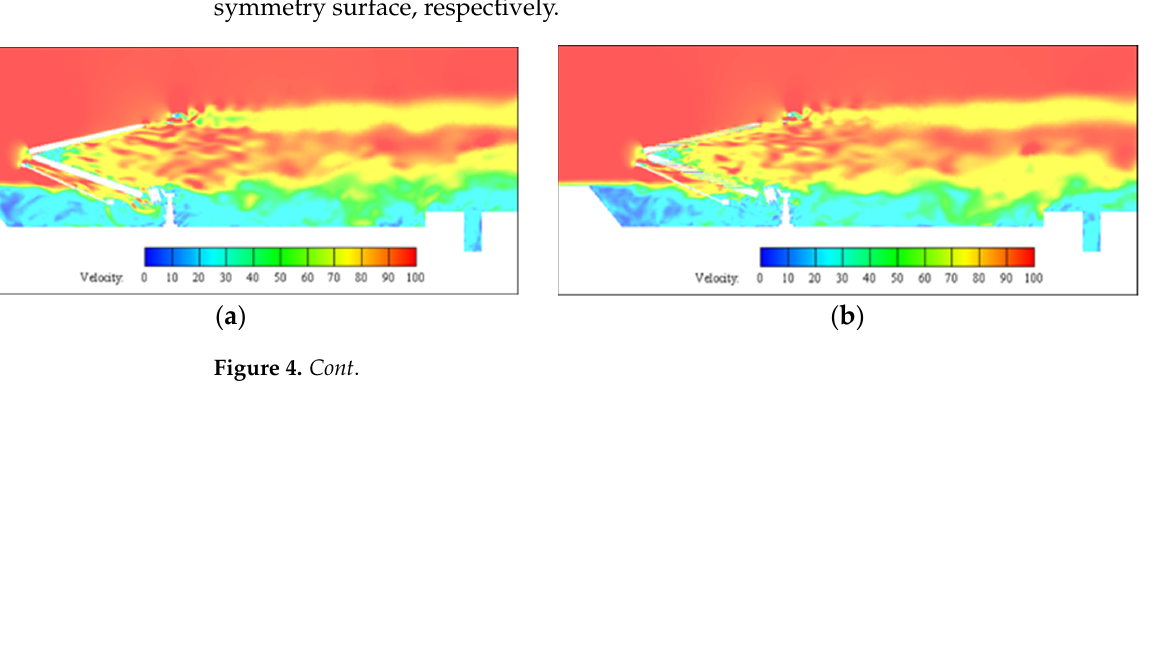
Table 3. Table of calculation grid parameters.